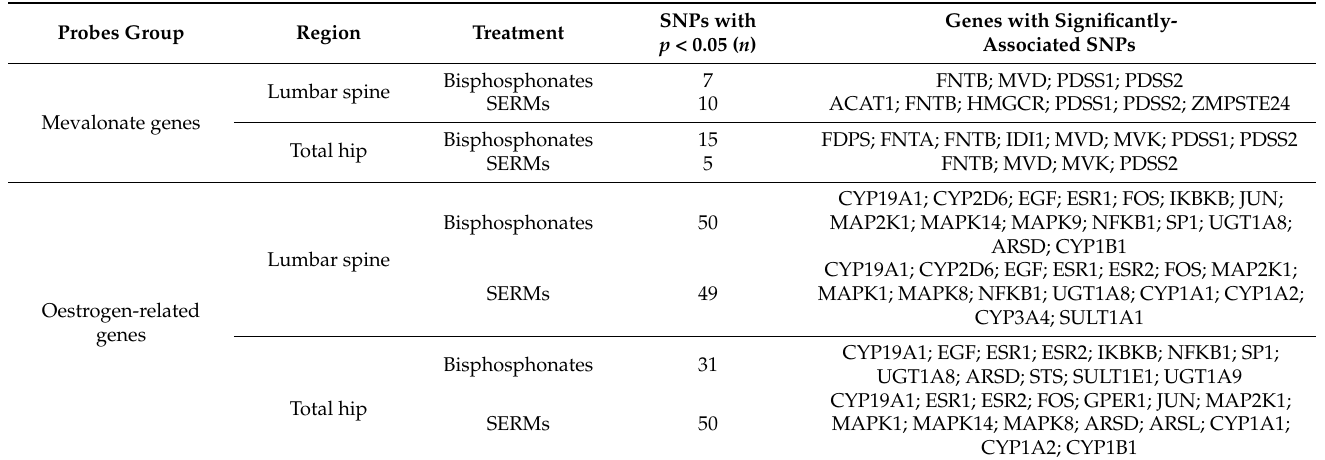
Table 2. Association of individual SNPs with drug